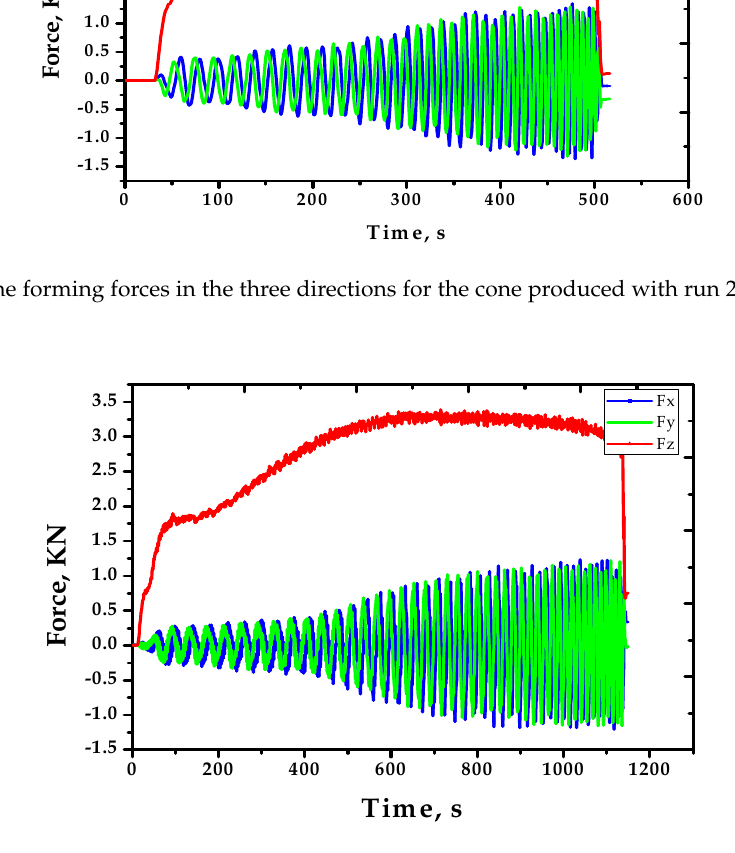
Figure 12. Forming forces in the three directions for the cone produced with run 3.